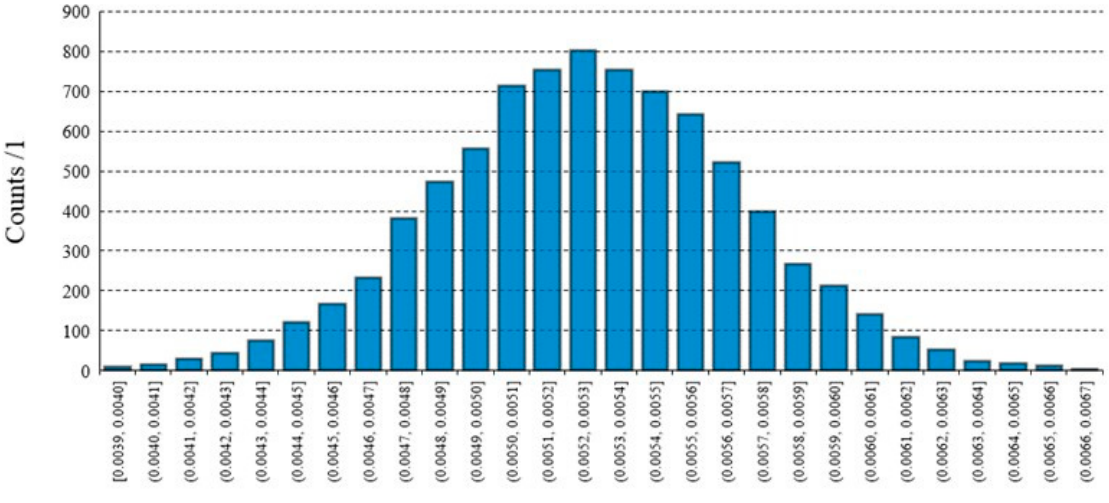
Figure 13. Sensitivity coefficient of the SBE35 s/n 0015 obtained with the Monte Carlo method with 8192 trials—best estimate a 1 = 0.0045 mK · MPa − 1 and variance σ = 0.0008 mK · MPa − 1 .